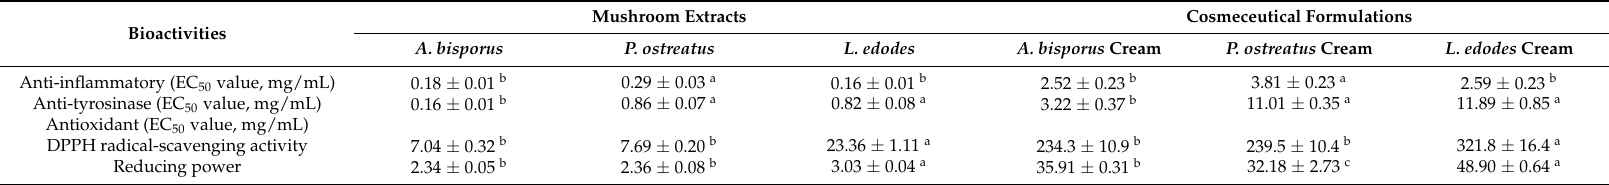
Table 2. Anti-inflammatory, anti-tyrosinase, and antioxidant activities of the mushroom ethanolic extracts and of the cosmeceutical formulations.